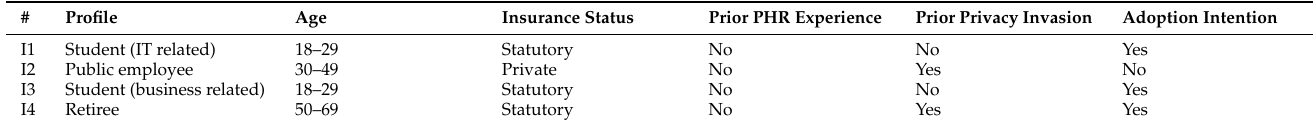
Table A2. Interviewees from Qualitative Study.